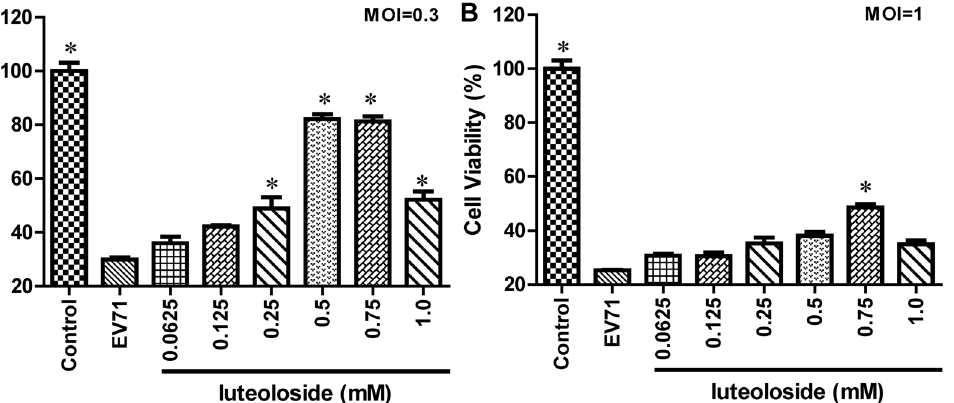
Fig 2. The antiviral effects of luteoloside against EV71 in RD cells. RD cells were infected 0.3 MOI (A) or 1.0 MOI (B) EV71 with or without different concentrations of luteoloside are shown. Uninfected cells were taken as control group. The cell viability was detected using MTS cell proliferation assay kit at 48 hpi. The viability of control group was set as 100%. Data shown are the means ± SE from 6 independent measurements ( n = 6). Asterisk meant the data differed from the EV71 group significantly at P < 0.05 level according to t -test.